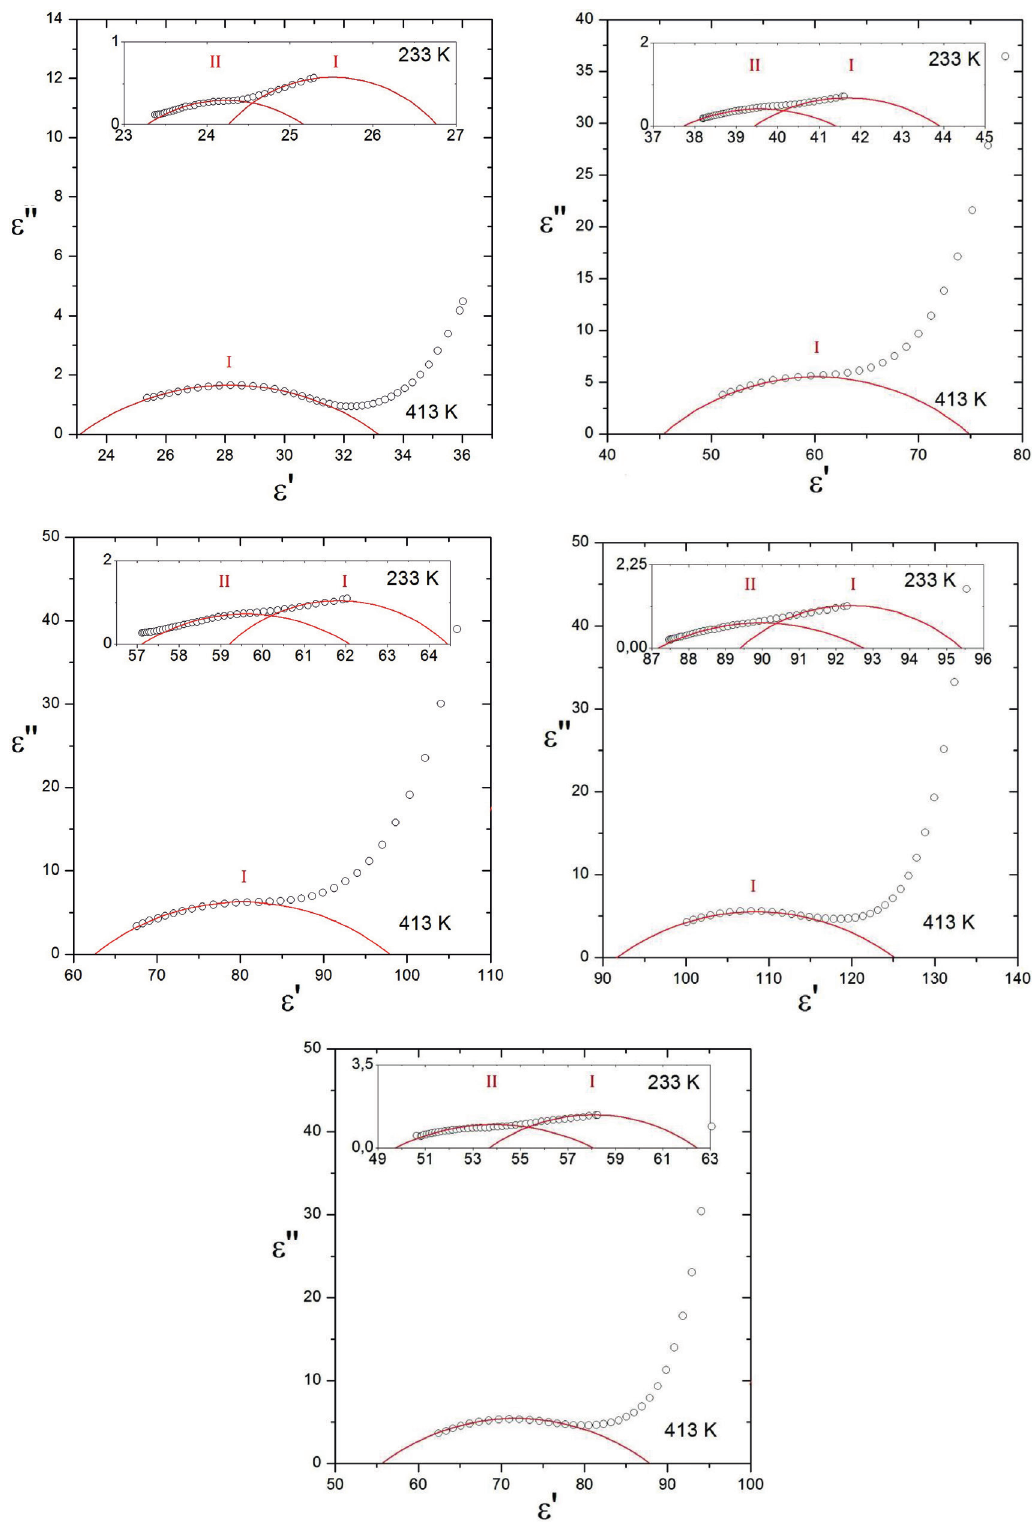
Fig. 4: Cole Cole diagrams for the samples x = 0, 0.25, 0.50, 0.75, 1.00 respectively from top to